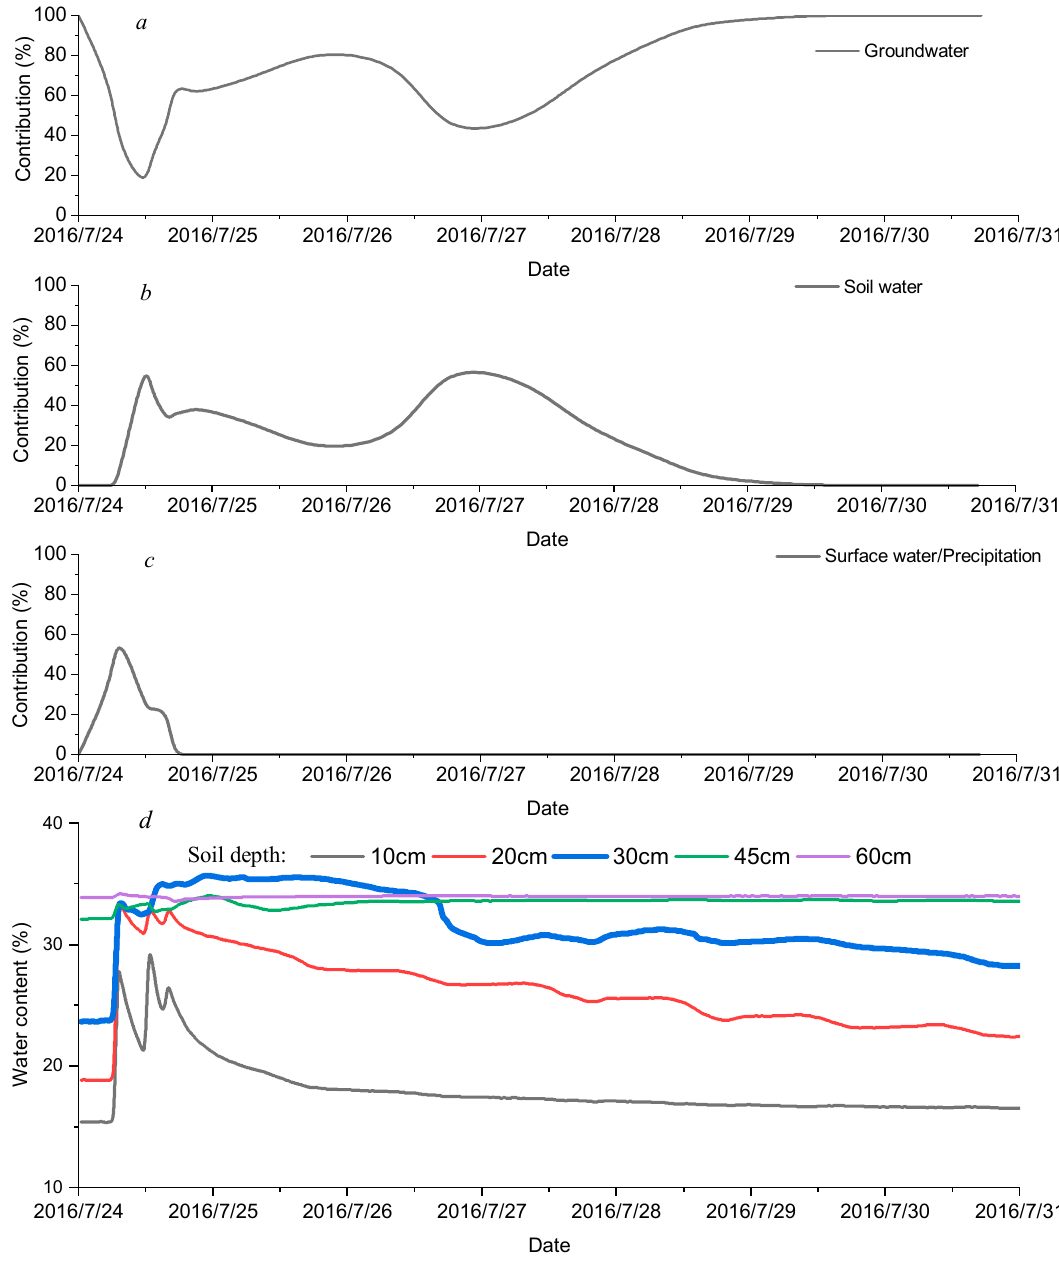
Figure 4. Percentage variations in the contribution of ( a ) groundwater, ( b ) soil water, and ( c ) surface water to streamflow and ( d ) percentage variation of water content in different soil depths during the experiment.